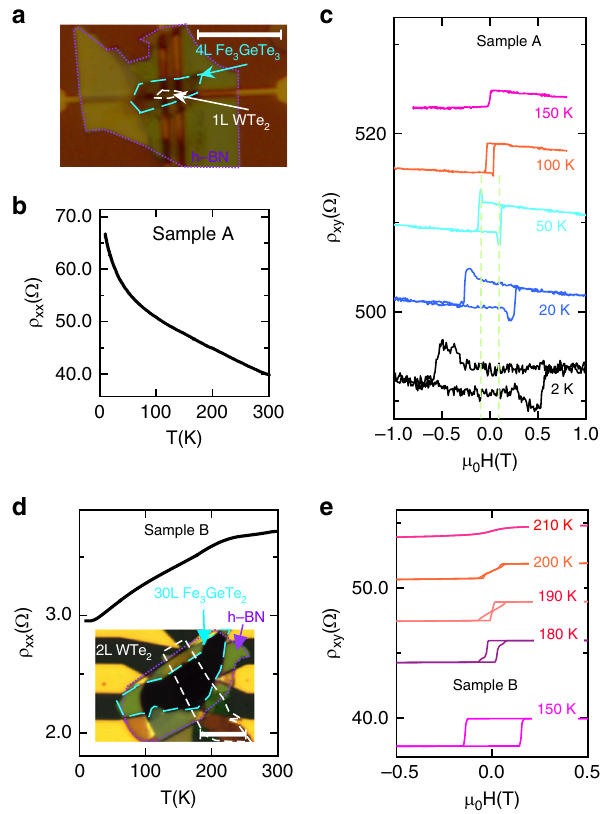
Fig. 2 Transport properties of WTe 2 /Fe 3 GeTe 2 heterostructures. a Microscopic image of sample A (1L WTe 2 /4L Fe 3 GeTe 2 ). Scale bar: 10 μ m. b Increasing longitudinal resistivity when temperature goes down for sample A. c Hall resistivity of the heterostructure shown in ( a ). Hall resistivity shows a peak and dip near the transition edge before the magnetization saturates, which is a sign of the topological Hall effect. An offset is used for clarity. d Longitudinal resistivity dependence on the temperature, showing the metallic behavior when temperature decreases. Inset shows the microscopic image of sample B (2L WTe 2 /30L Fe 3 GeTe 2 ). Scale bar: 10 μ m. e Hall resistivity of the heterostructure shown in ( d ). An offset is used for clarity. Magnetic fi eld is along out-of-plane